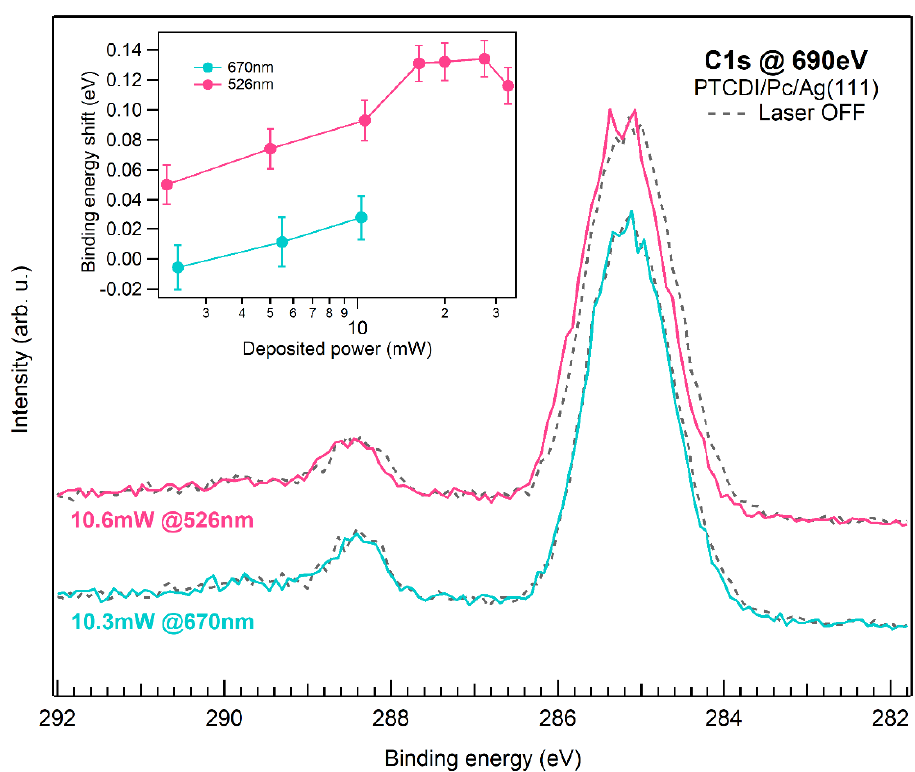
Figure 2. C 1s XPS spectra of PTCDI/Pc/Ag(111) measured with and without optical excitation at 526 nm and 670 nm. Upon illumination at 526 nm the C 1s core level lines shift to higher binding energy. In the inset the measured binding energy shifts as a function of deposited power for the two excitation energies are reported. Error bars represent one standard deviation.